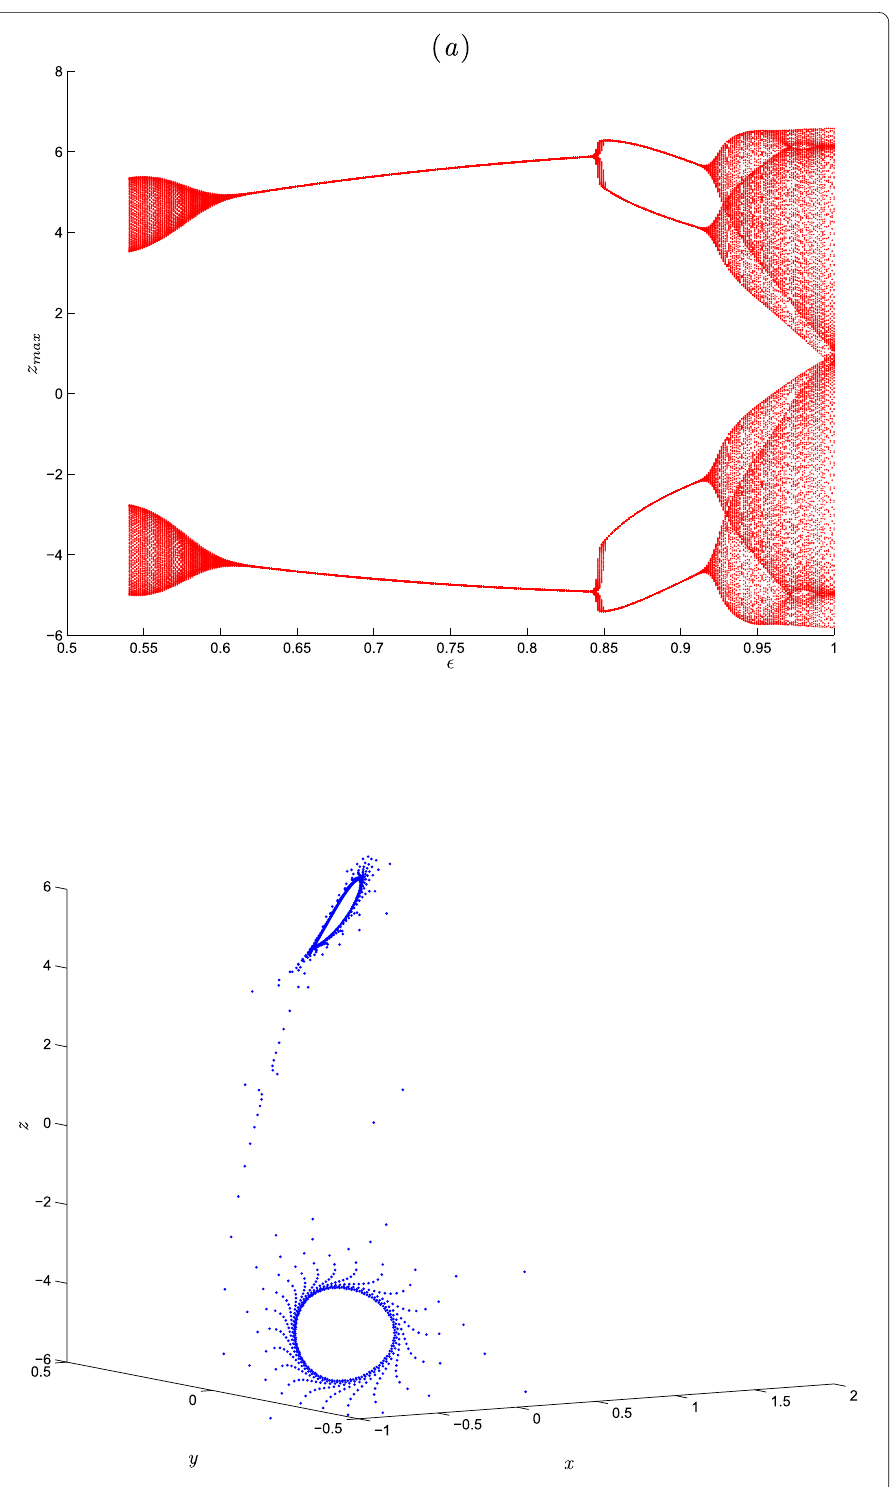
Figure 2 Bifurcation diagram and chaotic attractor of the 3D-FoWDS versus α 3 , for system’s parameter (